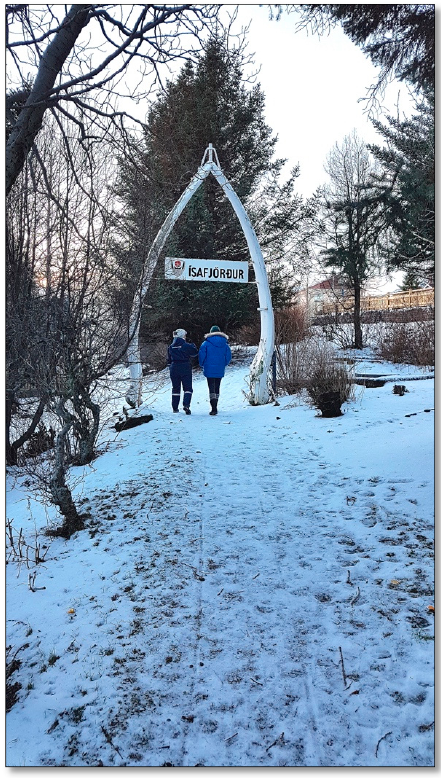
Figure 2. Jónsgarður Park. Figure 2. J ó nsgarður